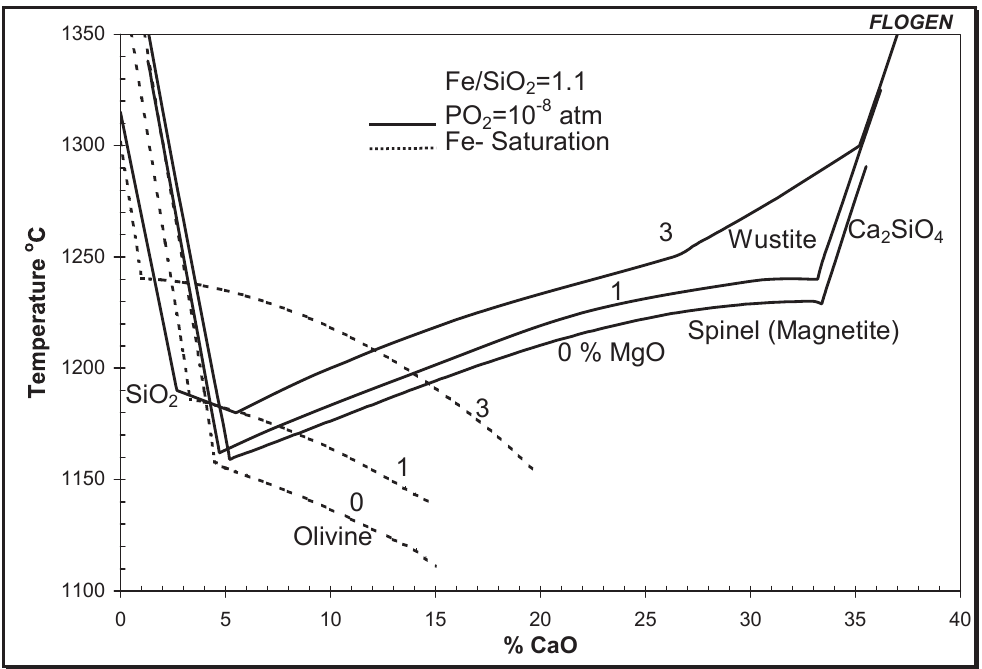
Figure 8. Effect of Al 2 O 3 on the liquidus temperature at P O